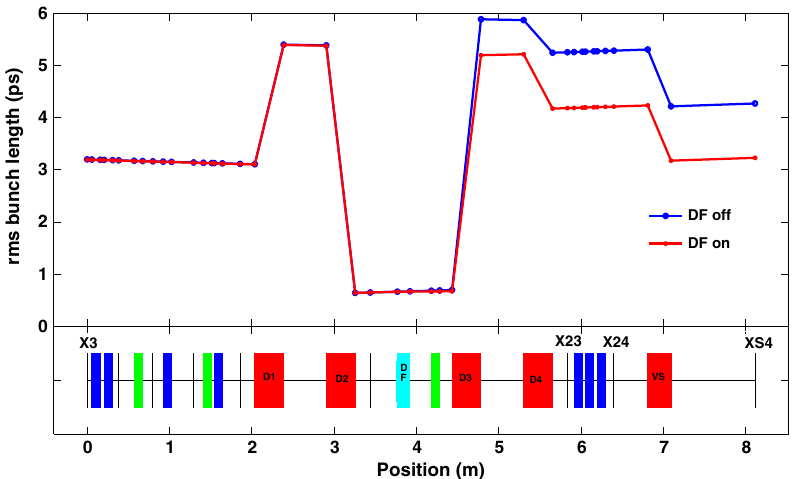
FIG. 15. Evolution of the rms bunch length along the emittance exchange beam line with and without the deflecting cavity powered on. The dipoles (D1, D2, D3, D4) are shown in red. The vertical spectrometer is marked as VS and the deflecting mode cavity is marked as DF. Regular quadrupoles are shown in blue and skew quadrupoles are shown in green. Vertical lines refer to beam imaging